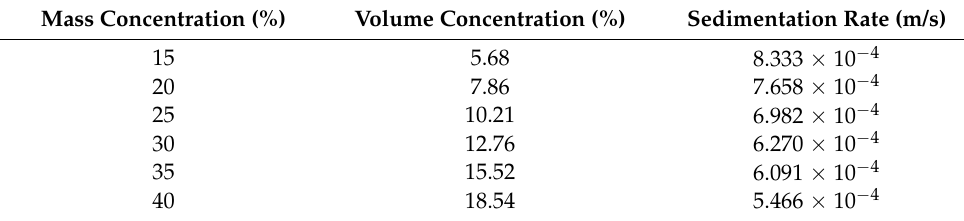
Figure 6. Unsupervised learning recognition result of interface settlement. Table 6. Tailings settling